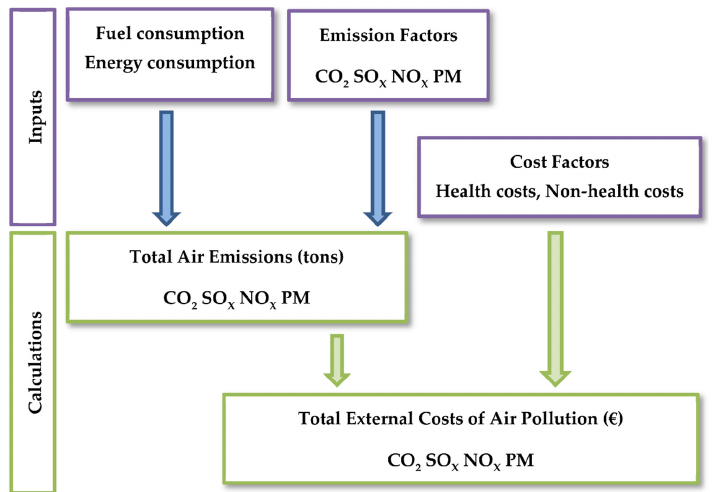
Figure 1. Total external costs methodological framework.